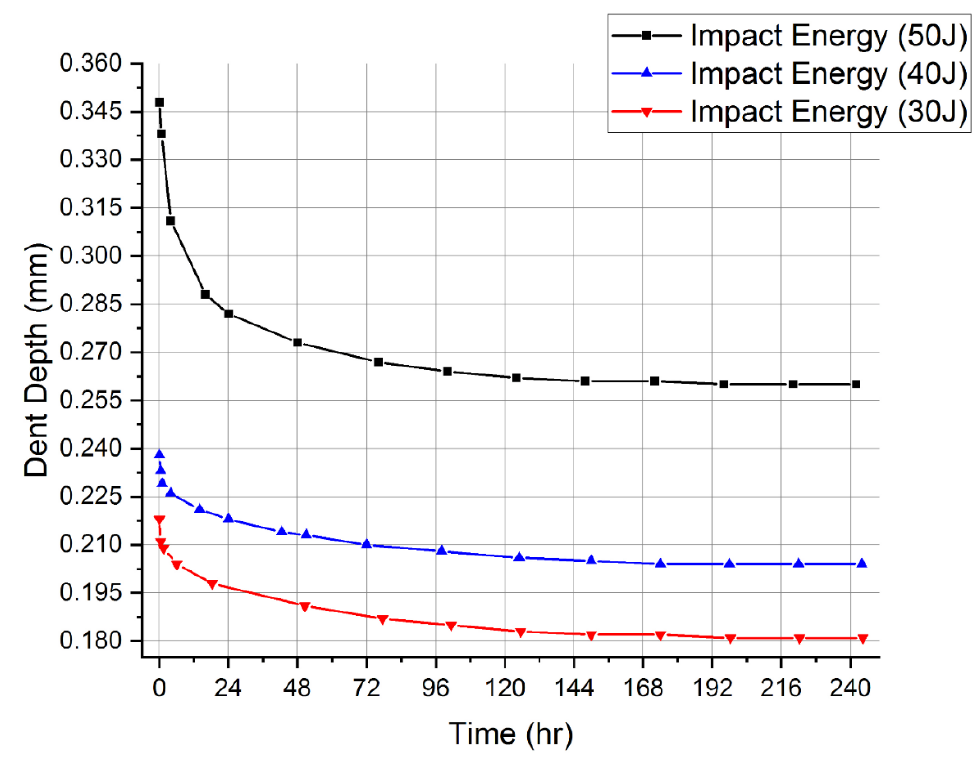
Figure 5. Indentation rebound: depth vs. time graph. Figure 6 shows a 40 J impacted specimen from the impacted side and the back side. The back side surface of the specimen remains undamaged.